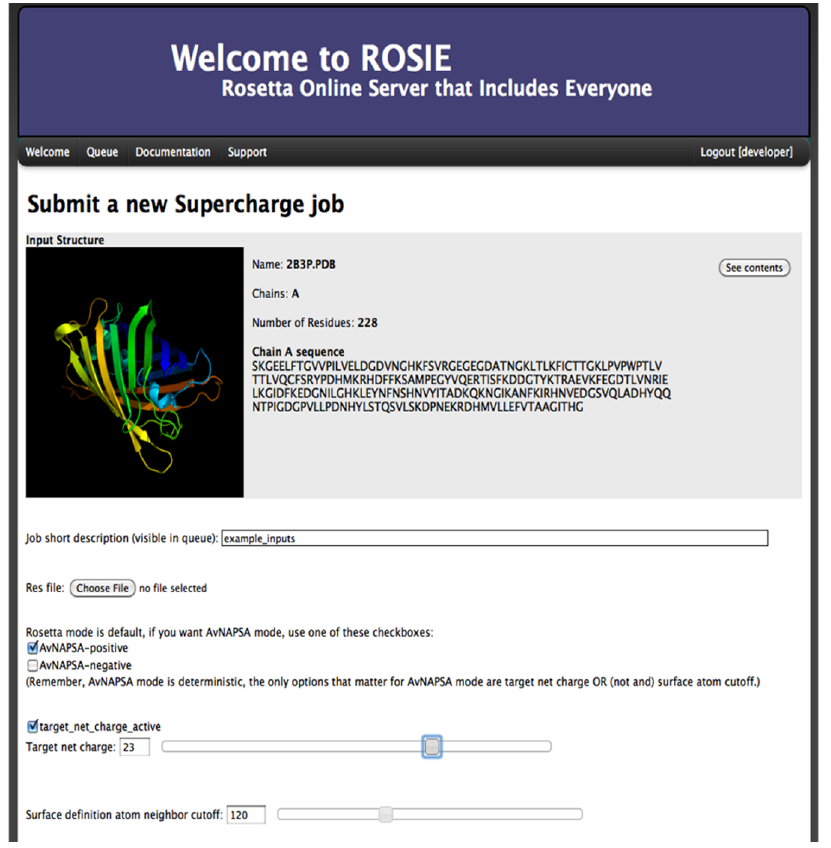
Figure 3 . User interface for running the supercharge protocol on the ROSIE web server . The user uploads a PDB, then uses checkboxes or sliding bars to specify the protocol options, not all options are shown here (Table 1). Job status and protocol documentation can be viewed in the Queue and Documentation tabs.